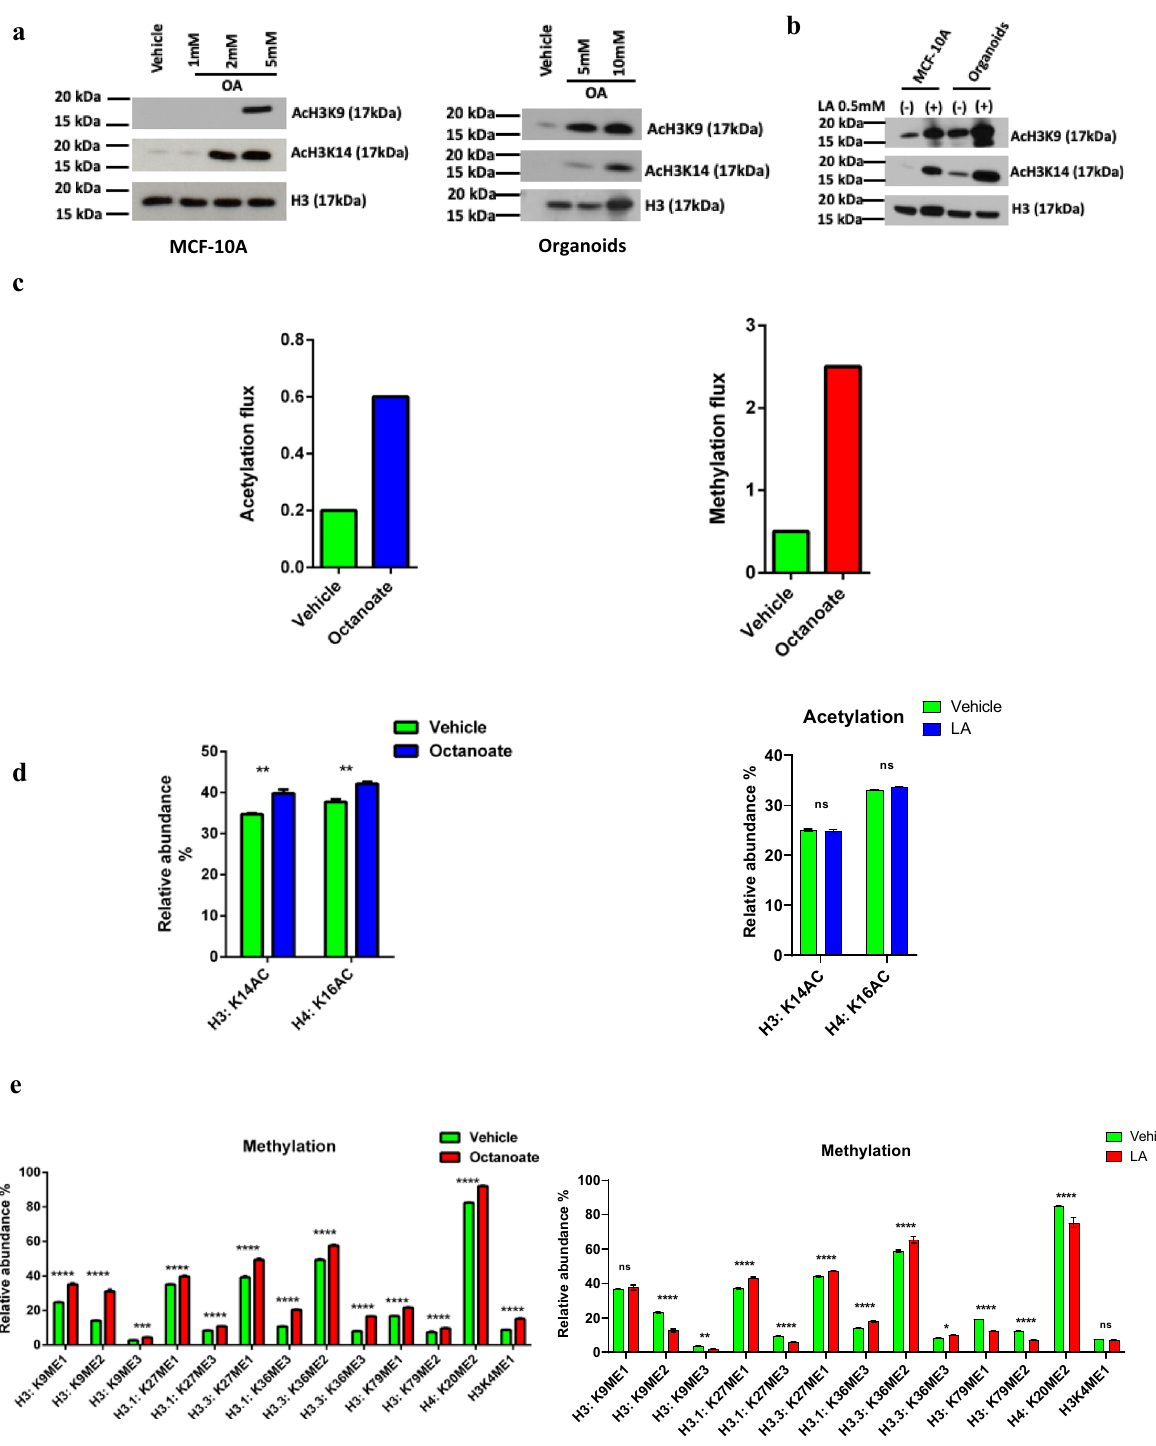
Fig. 6 Fatty acids drive histone modi fi cations and metabolic fl ux. Western blot of histone acetylation at H3 lysine K9 and K14 in MCF-10A cells and organoids treated with a octanoate and b linoleic acid. c The effect of octanoate treatment on histone acetylation and methylation fl ux in MCF-10A cells predicted using genome-scale metabolic modeling. Proteomic acetylation ( d ) and methylation ( e ) pro fi ling measured by mass spectrometry of MCF-10A cells treated in triplicate with 5 mM octanoate for 24 h in a complete media compared to vehicle (left) and 0.5 mM linoleate for 24 h in complete media compared to vehicle (right) (mean ± s.d.). Two-way ANOVA was performed to determine the statistical signi fi cance and corrected for multiple comparisons using Sidak test (**** P < 0.0001, *** P < 0.001, ** P < 0.01, * P < 0.05, ns not signi fi cant). f Heatmap of reaction fl ux differences predicted by metabolic modeling to be differentially active ( p -value < 0.01) between control and treatment (increased fl ux in red, decreased fl ux in blue). The corresponding pathways (subsystem) that each reaction belongs to is listed in the